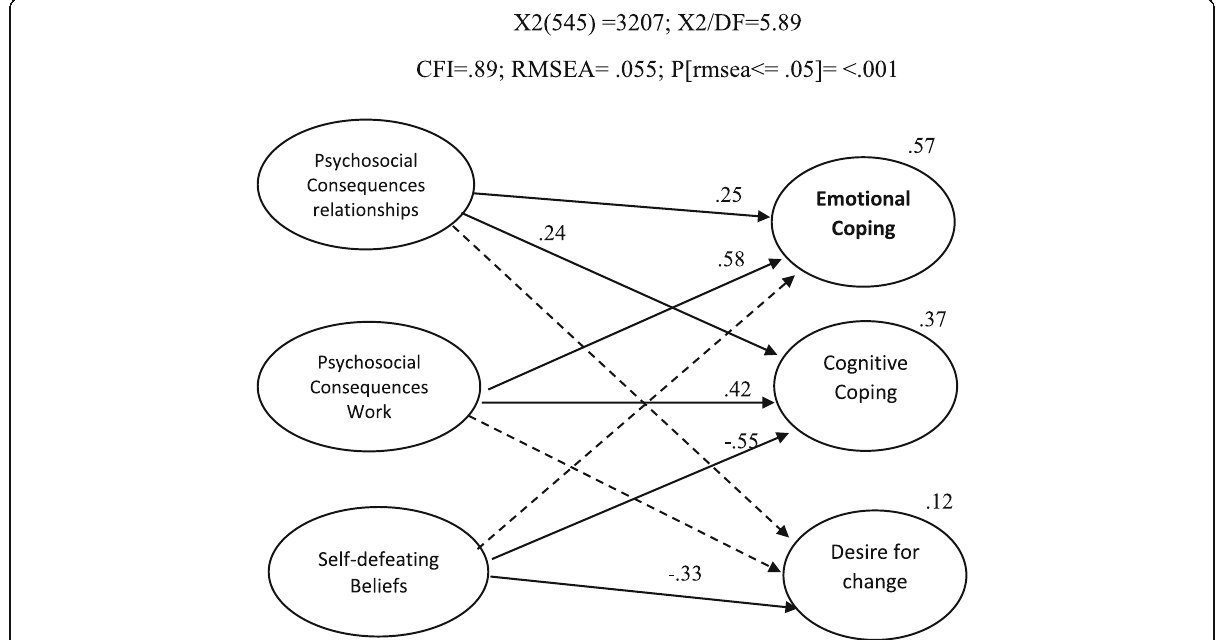
Fig. 3 SEM — psychosocial uncertainty and emotional coping strategies towards